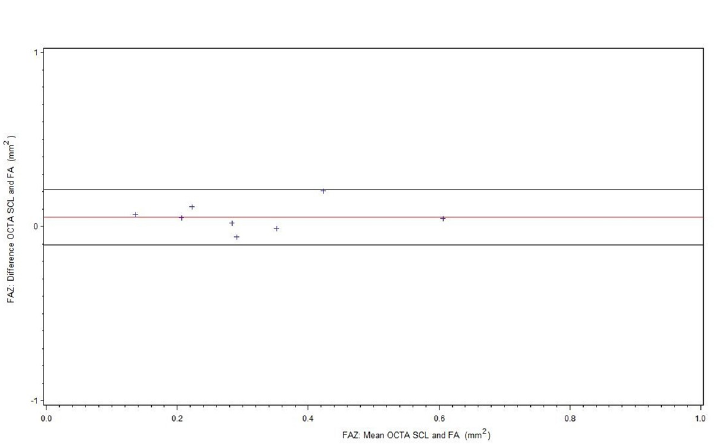
Fig 5. FAZ: Bland-Altman-Plot for the agreement of FA and OCTA SCL in patients without ME.